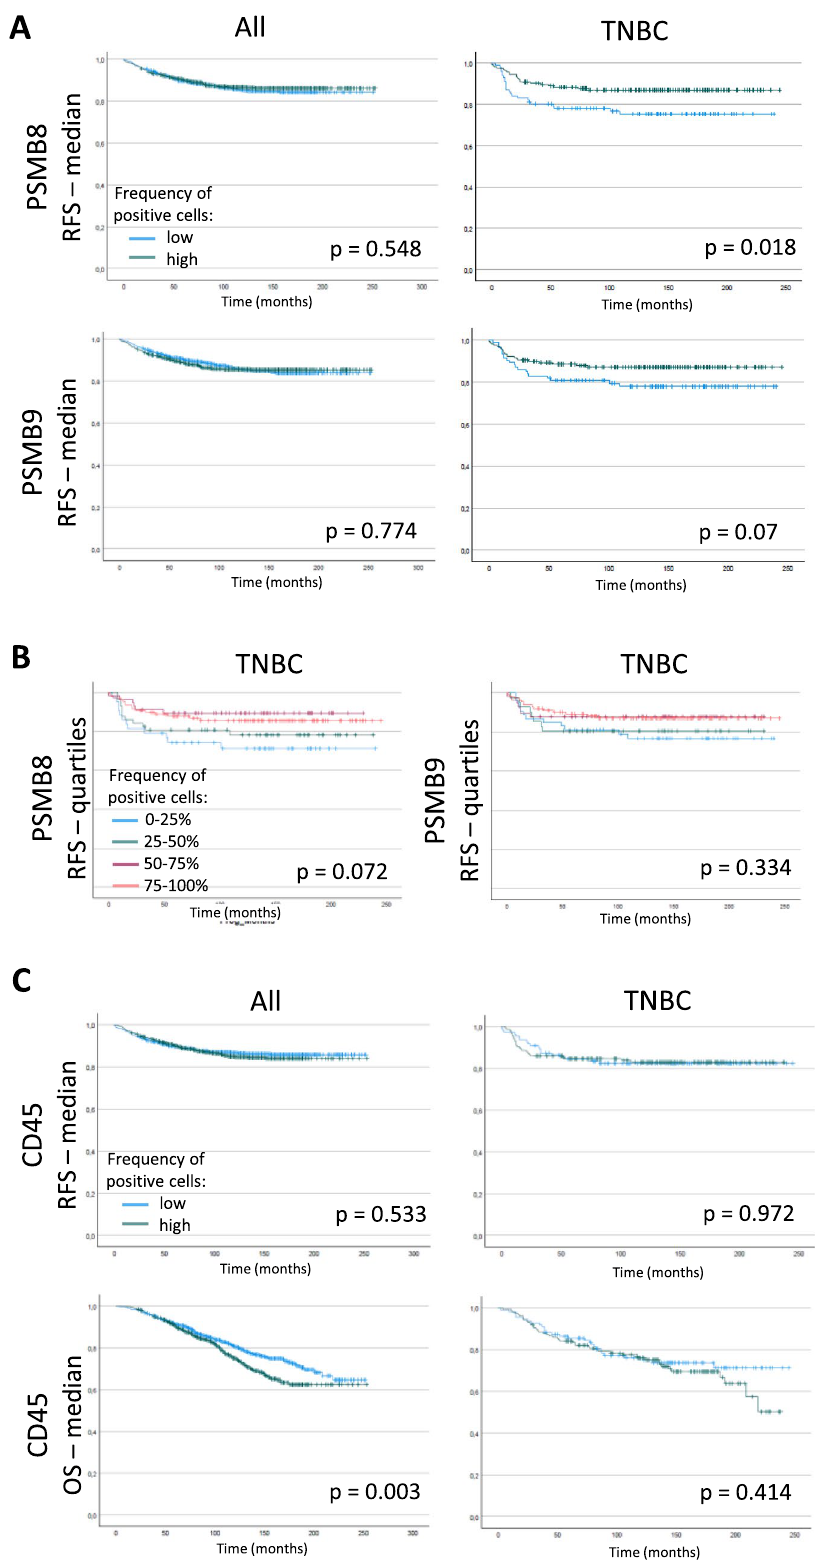
Figure 2. Overall high PSMB8 and PSMB9 protein expression is associated with a trend to better outcomes in TNBC patients specifically. RFS according to the amount of PSMB8- and PSMB9-expressing cells of all breast cancer subtypes together as well as TNBC patients divided according to ( A ) their median or ( B ) by quartiles of expression. ( C ) The same analysis was performed for the RFS, as well as the OS of the patients according to the median CD45 protein expression. For median expression, the green and blue lines correspond to high and low frequency of positive cells, respectively; for quartiles expression, blue, green, purple and red lines correspond to the lowest to highest frequency of positive cells, respectively. Statistical analyses by Logrank test: differences are considered statistically significant when p <